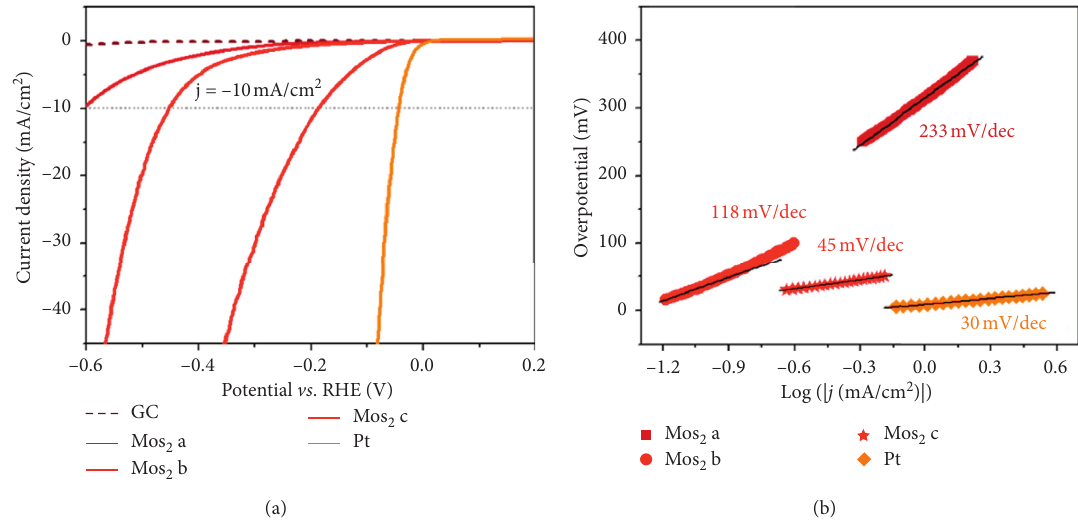
Figure 26: (a) LSV polarisation curves of MoS 2 and commercial Pt electrocatalysts as well as their corresponding (b) Tafel plots [152].